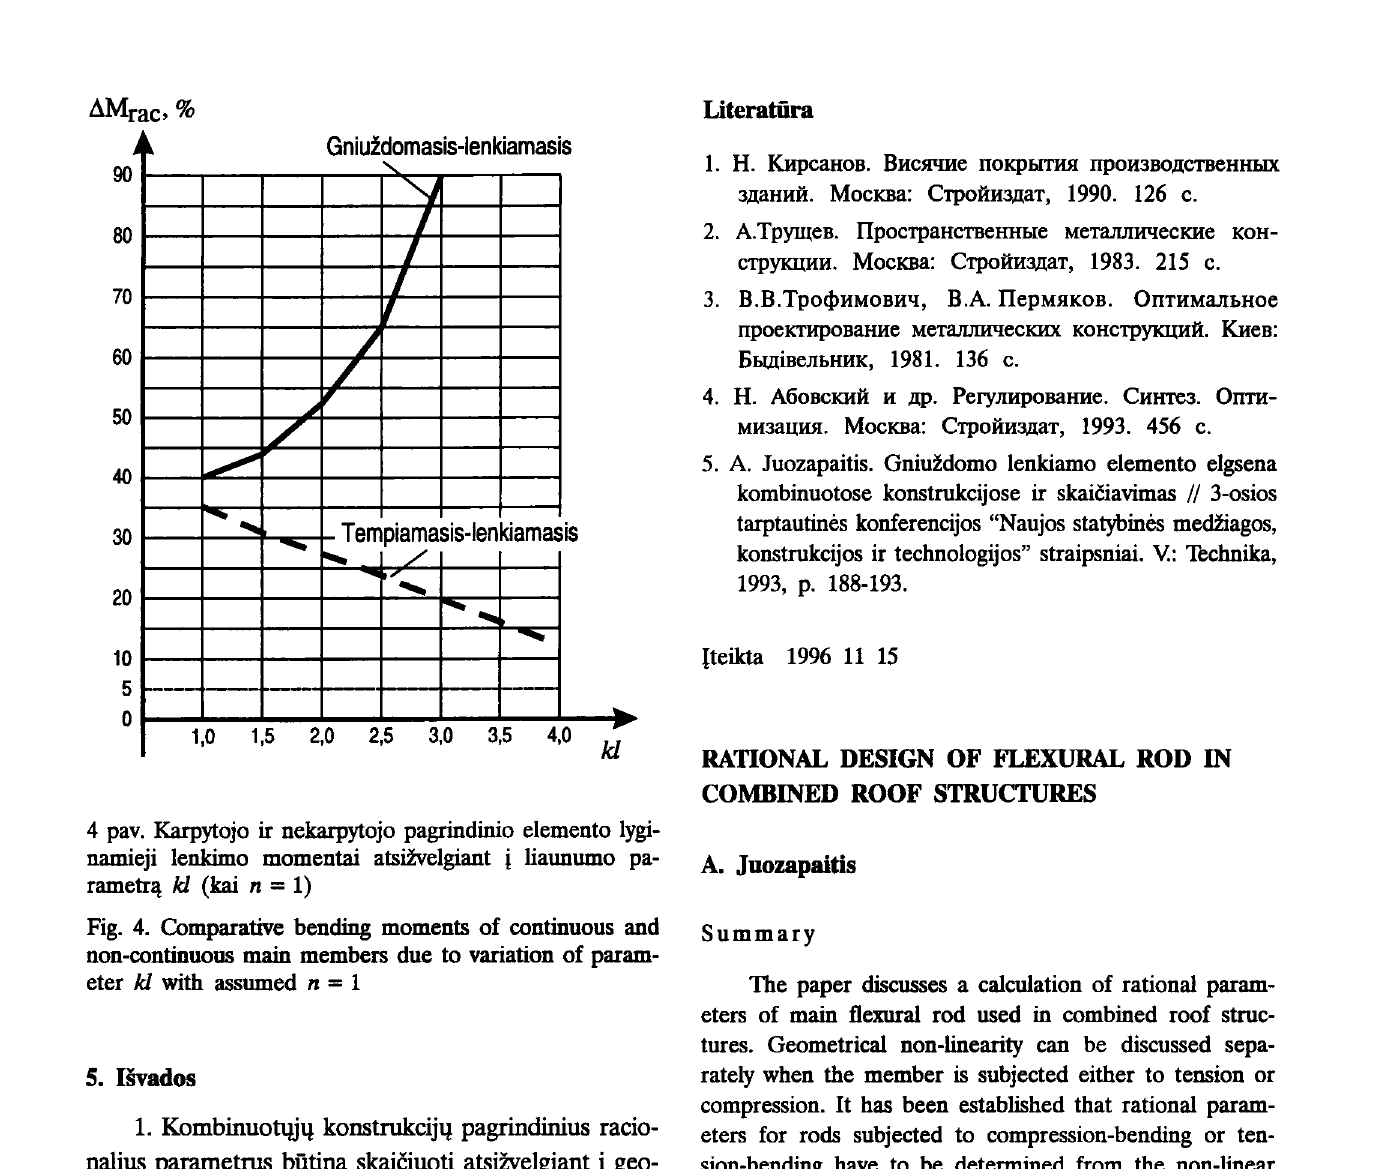
Fig. 4. Comparative bending moments of continuous and non-continuous main members due to variation of param eter kl with assumed n = 1